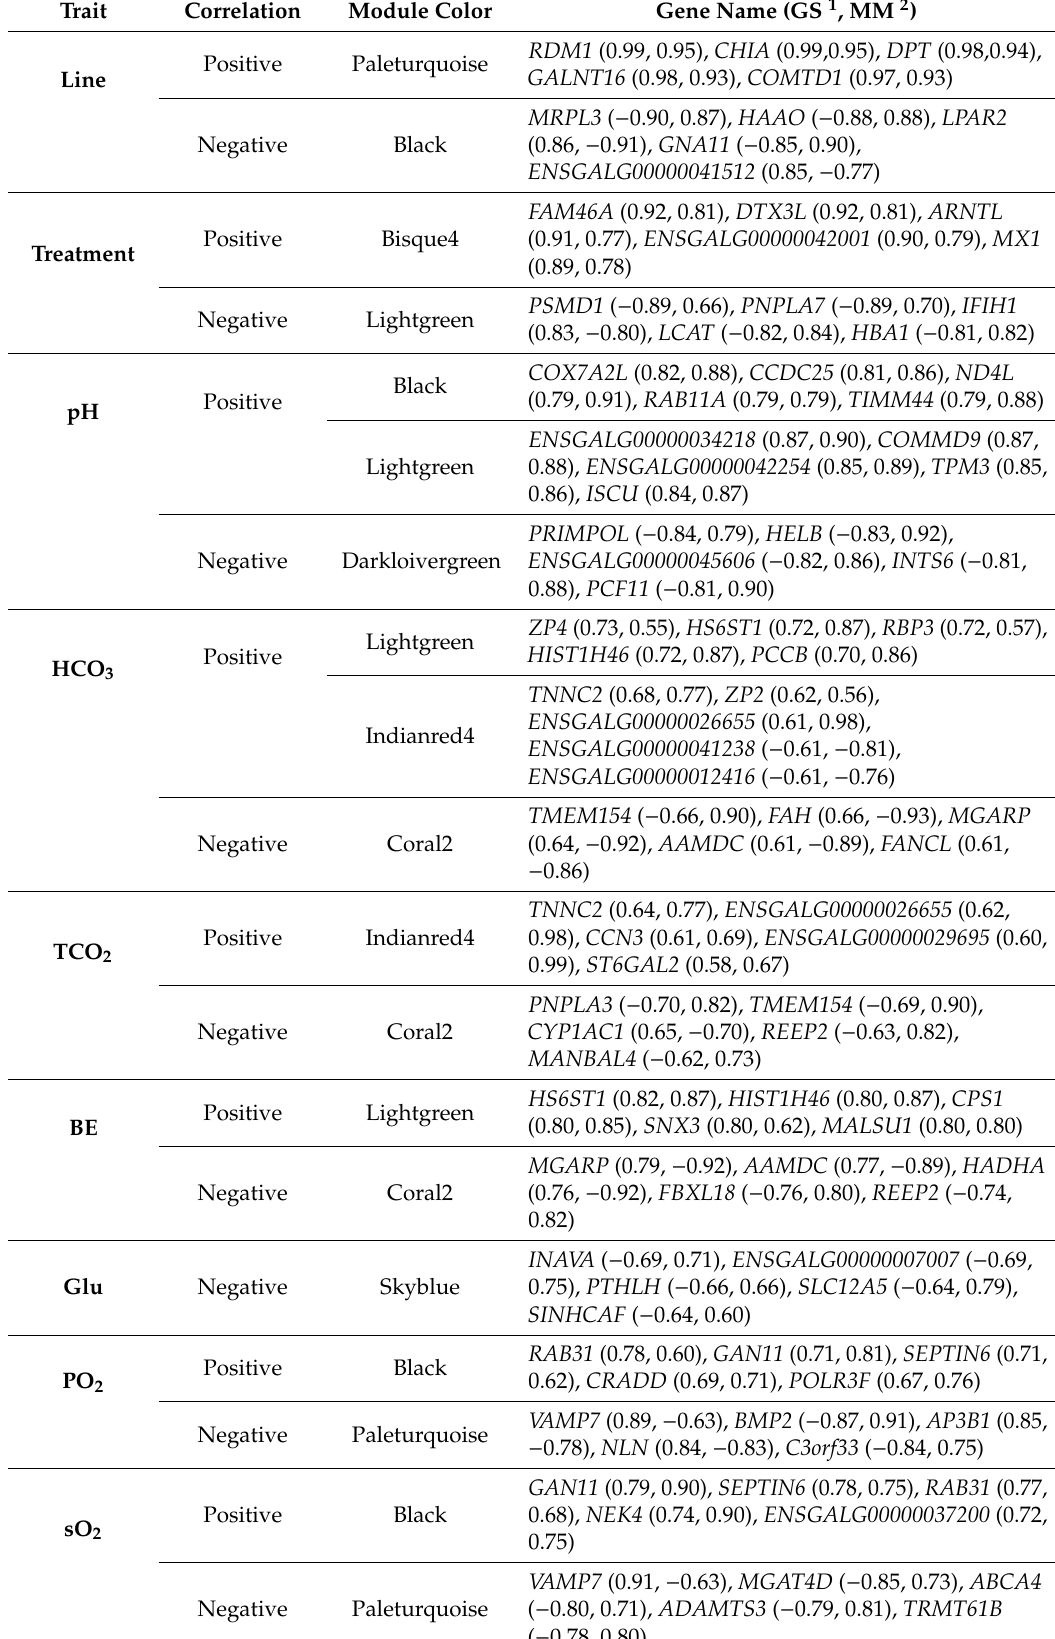
Table 7. Top five driver genes for gene modules that were significantly associated with a factor (line, treatment or blood phenotypes) for CH&NDV